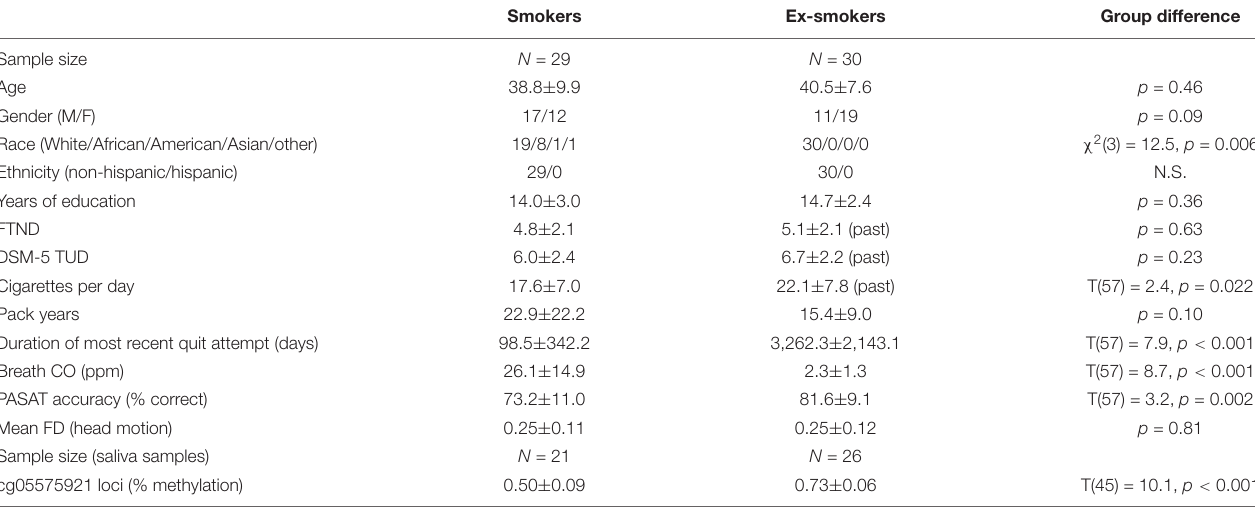
TABLE 1 | Demographic characteristics and tobacco use histories of smokers and ex-smokers (M ± SD).